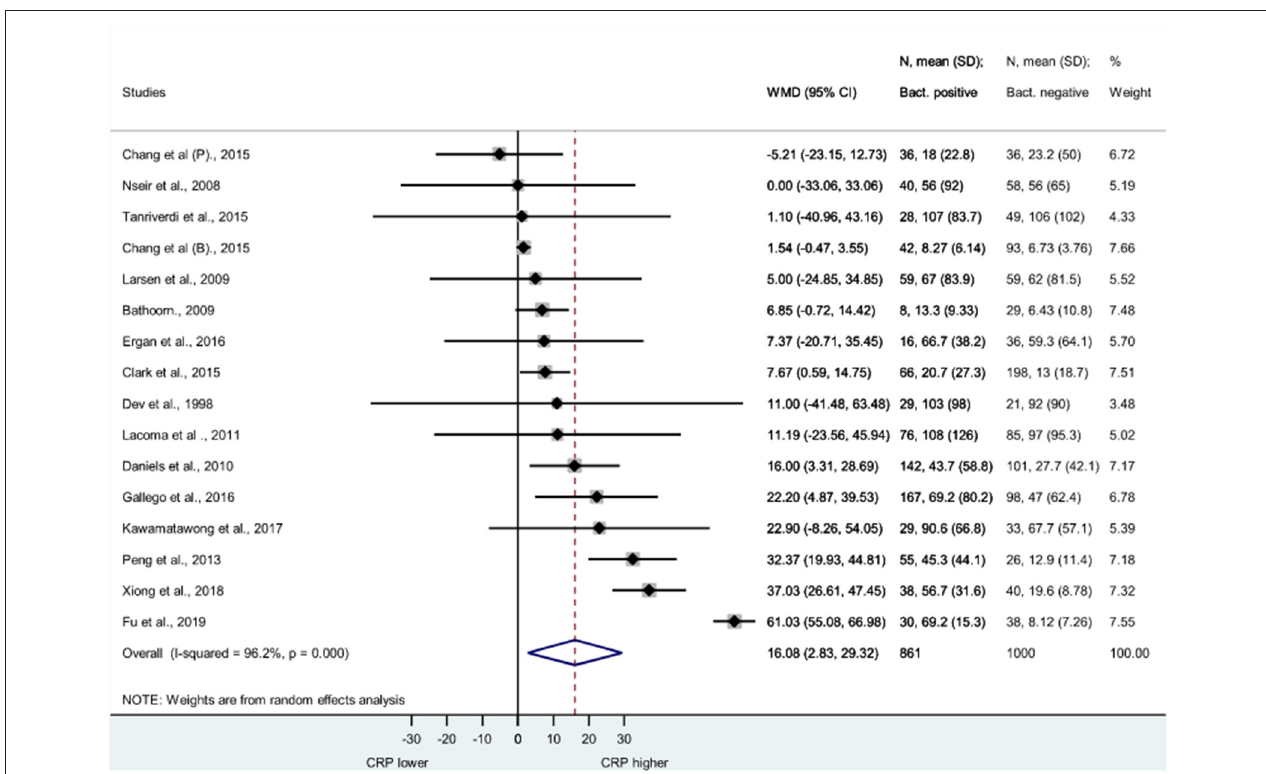
FIGURE 2 | Forest plot of serum C-reactive protein. CRP was measured in AECOPD cases with bacteria positive and bacteria negative microbiological cultures. CRP was measured in (mg/l) in each study. CRP is significantly elevated in bacterial cases than non-bacterial cases. WMD = 16.06, 95% CI: 2.83–29.32, p = 0.017. AECOPD, acute exacerbation of chronic obstructive pulmonary disease; CRP, C-reactive protein; SD, standard deviation; WMD, weighted mean difference; CI, confidence